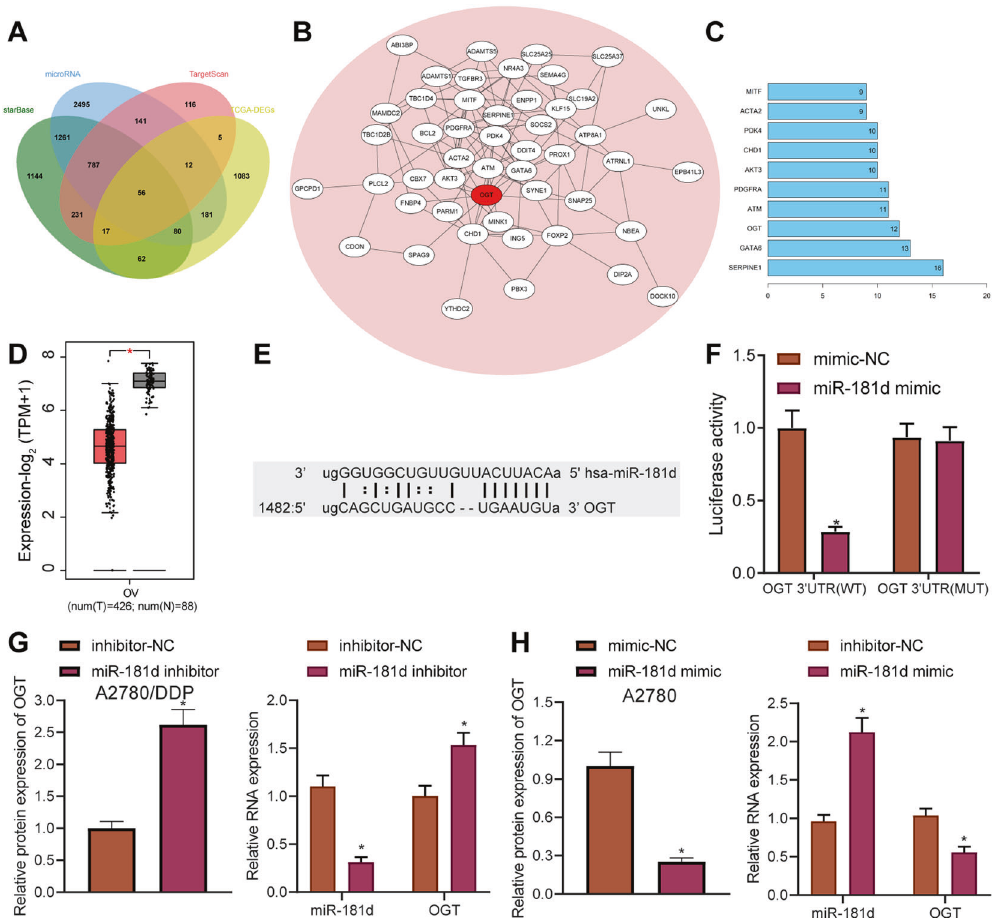
GEPIA and the candidate target genes predicted by the three databases. The middle part represents the intersection of the four sets of data. B Candidate target gene interaction network diagram. Each ellipse in the fi gure represents a gene, the lines between the ellipses indicate the presence of interaction between genes, and the red represents OGT. C The degree value statistics of core genes in the gene interaction network diagram. The more interacting genes represent the higher degree value and higher core degree. The x -axis in the fi gure represents the degree value, and the y -axis represents the gene. D Differential expression of OGT gene in OC and normal samples in the TCGA and GTEx databases. The x -axis indicates the sample type, the y -axis indicates the expression, the red box plot indicates the tumor sample, and the gray box plot indicates the normal sample (T Tumor, N Normal, * p < 0.01 versus normal samples). E Putative miR-181d binding sites in the OGT 3 ′ UTR predicted by the microRNA.org database. F Binding of miR-181d to OGT con fi rmed by dual luciferase reporter assay. G Western blot